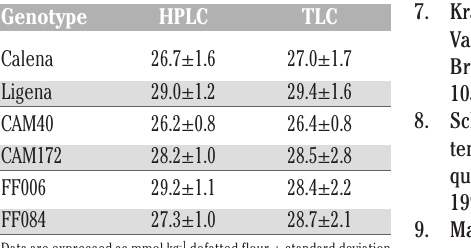
Table 1. Glucosinolates content (GSL1+ GSL2+GSL3) in flour of six Camelina sati- va genotypes determined by high-perform- ance liquid chromatography and thin layer chromatography methods.